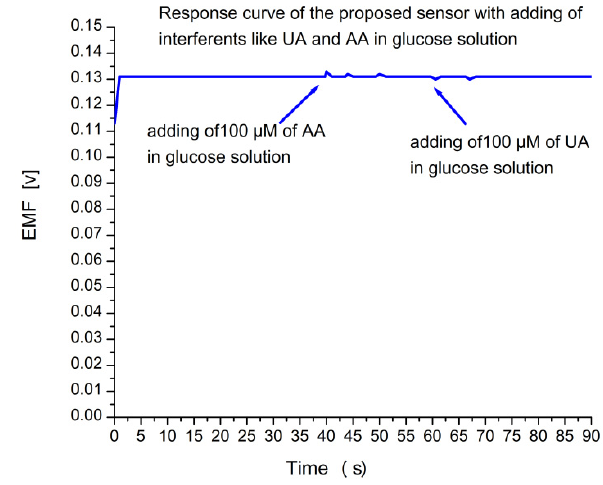
Figure 3. Calibration curve showing the study of interferences with time trace line of output response (EMF) change with time after adding 100 µM ascorbic acid and uric acid in 1 mM glucose solution.